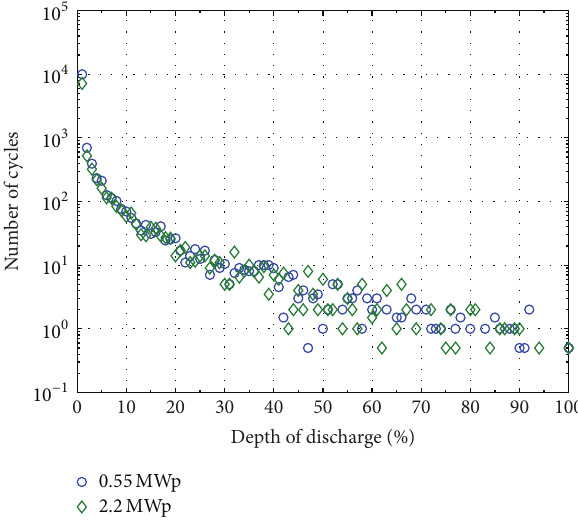
Figure 11: Observed number of energy storage charge-discharge cycles as a function of the depth of discharge for compensating the 0.55 MWpPVgeneratorusingthreedifferentrampratelimitsduring the year 2012. The depth of discharge is calculated with respect to the observed effective energy capacity requirements shown in Figure 5.